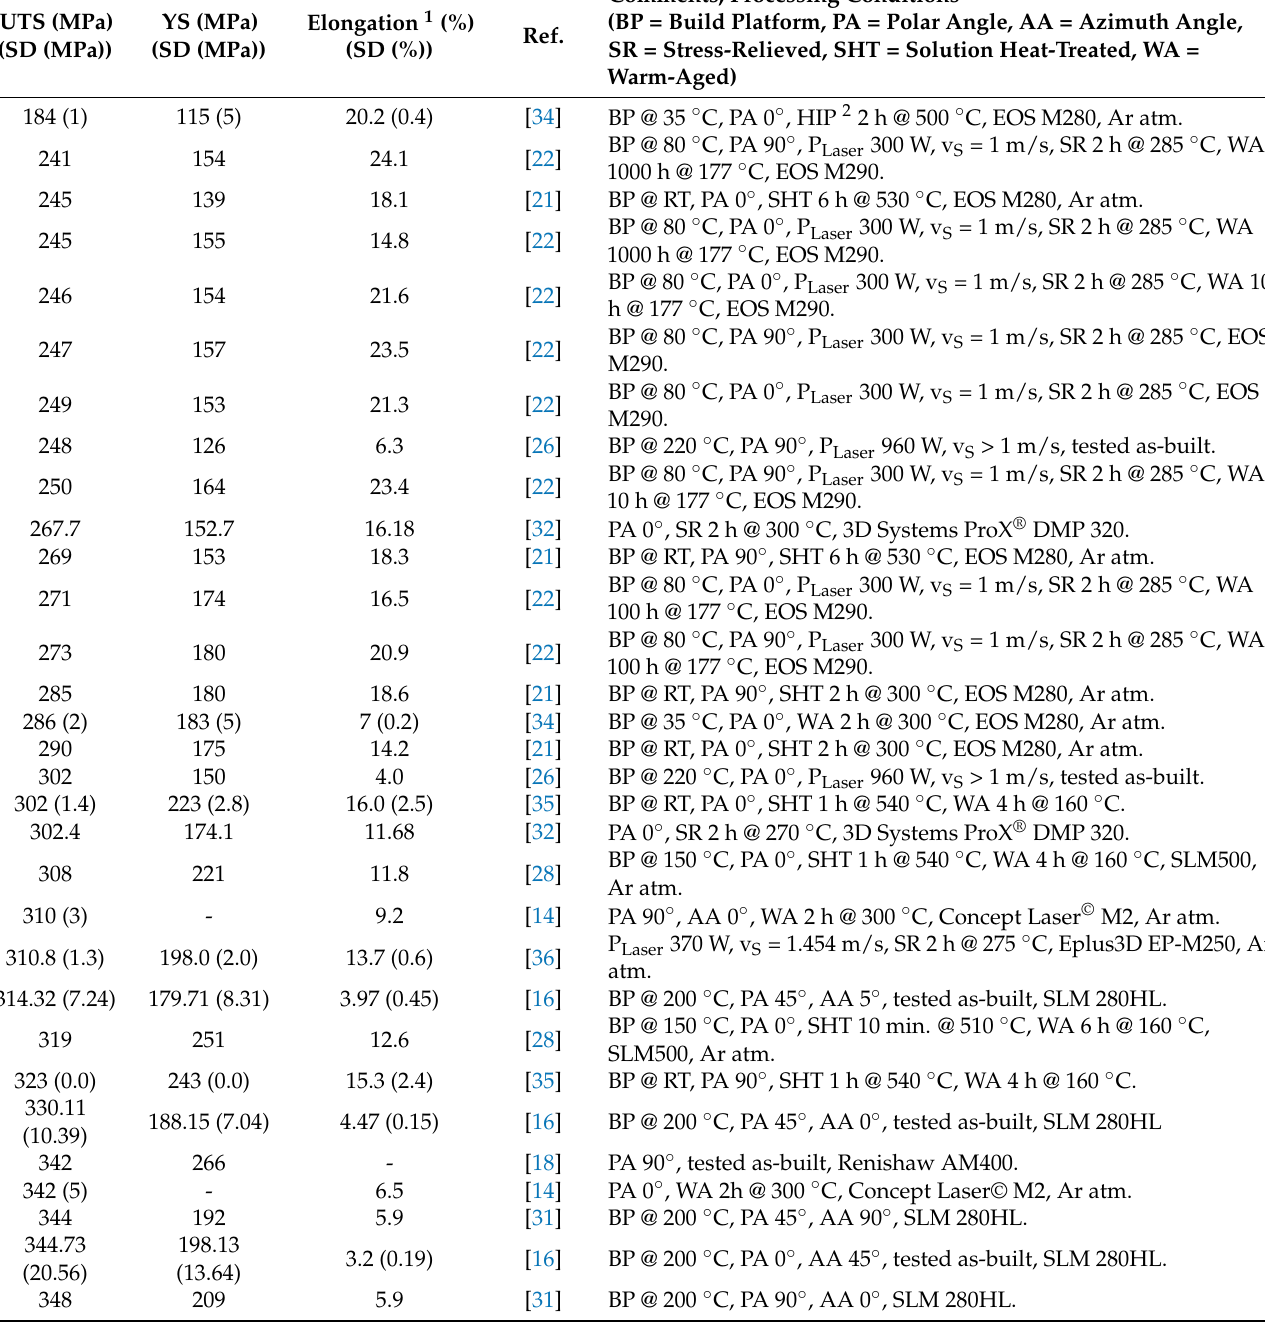
Table A1. Overview of ultimate tensile strength (UTS), yield strength (YS) and elongation at failure data as depicted graphically in Figure 1 with additional background information on material state, process parameters and boundary conditions. As definitions of polar and azimuth angles sometimes vary in the literature, these have been transformed to match the definitions provided in Figure 2 above. The data are sorted not by source, but in ascending order based on the reported UTS